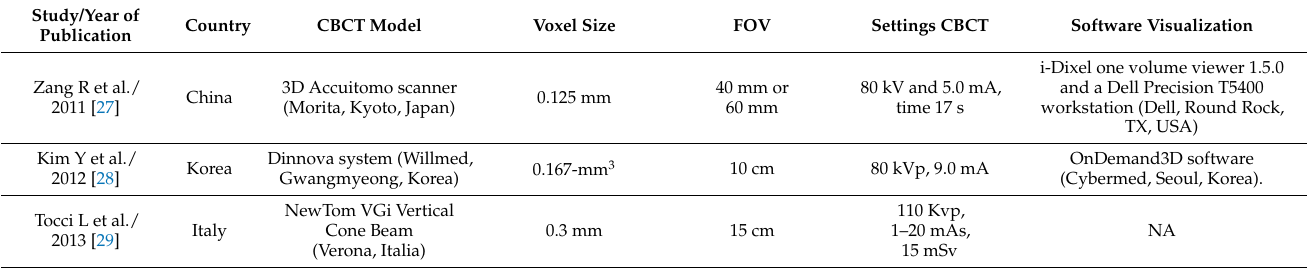
Table 1. Cone-beam computed tomography parameter values of each